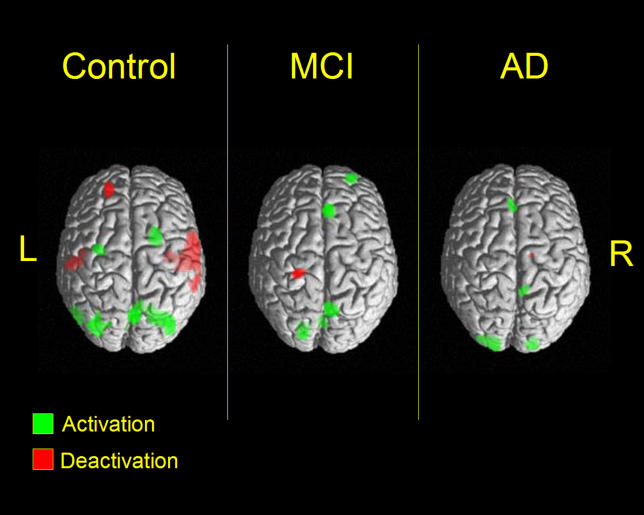
rCBF Changes in Control Individuals and Patients with MCI and AD during Navigation TaskResults are surface-rendered and superimposed on a standard MRI template. Green indicates significant increase of rCBF, and red indicates significant decrease of rCBF during active navigation (results are displayed at p < 0.001).